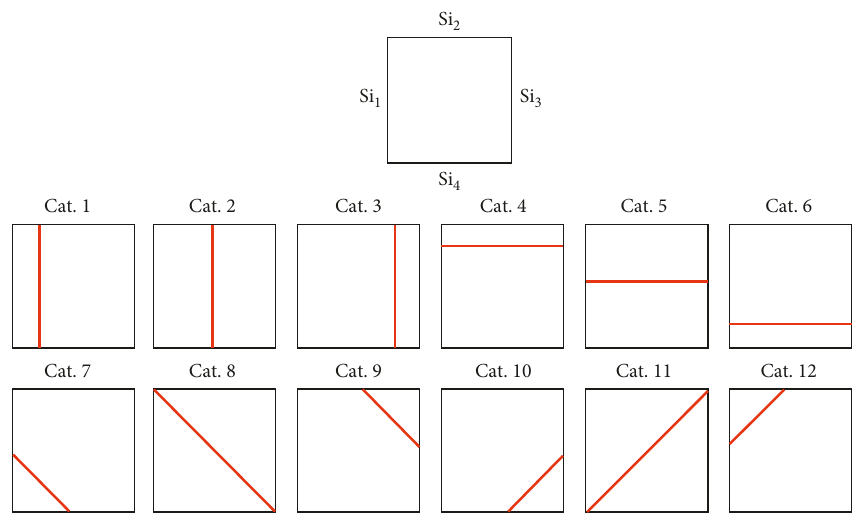
Figure 12: Raw plot based on the position of each crack in a single tile for all 12 categories that contain a crack.